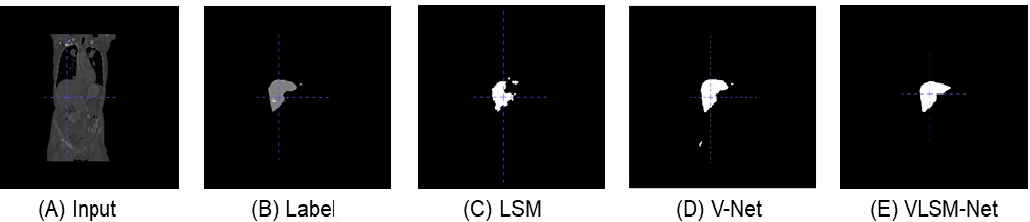
Figure 6. From the front view, the predicted images of different segmentation models in LiTS da- taset. ( A ) The original input image. ( B ) The label image. ( C ) The predicted image of the LSM. ( D ) The predicted image of the V-Net model. ( E ) The predicted image of the VLSM-Net.